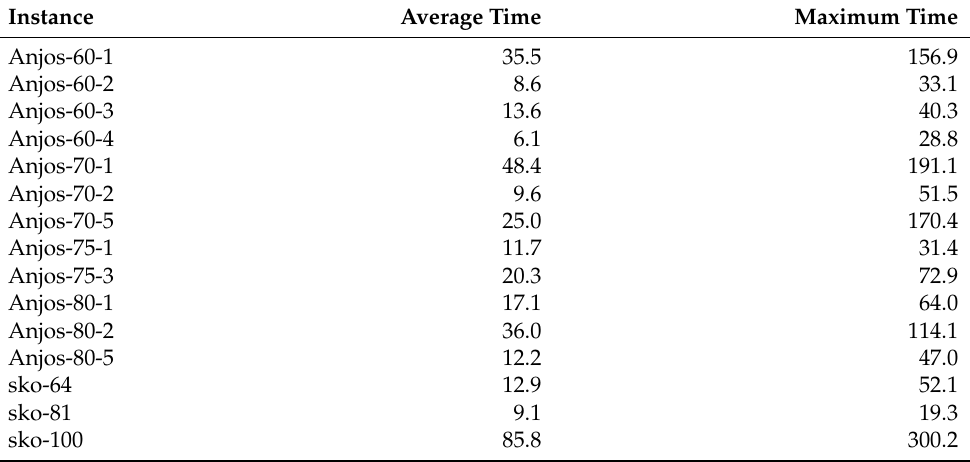
Table 8. Time (in seconds) taken by SA-VNS-1-1 to reach the best solution in all 30